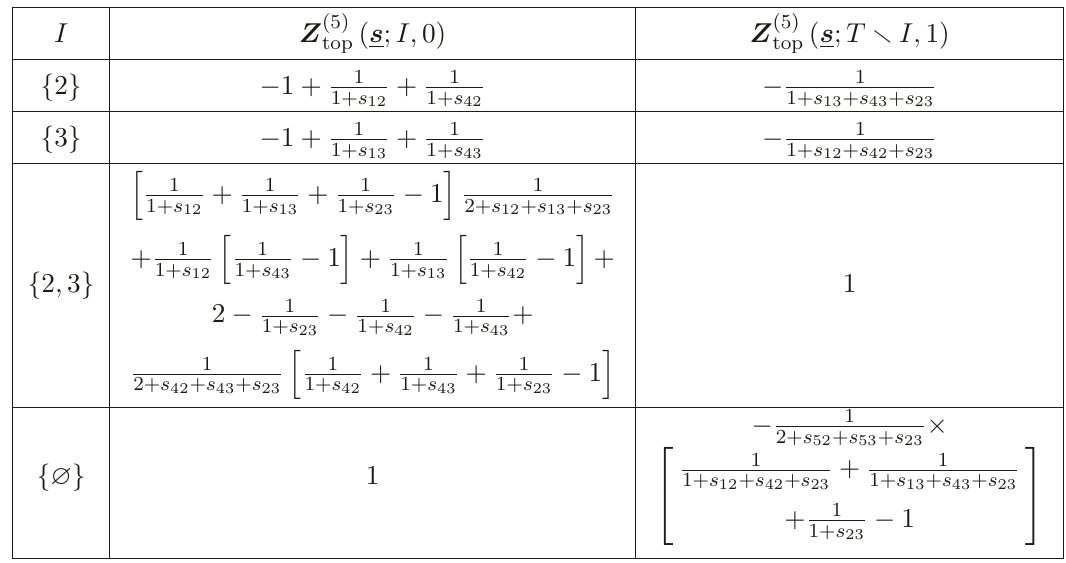
( s ; I, 0) and Z (5) ( s ; T r I, 1) is written for each top top